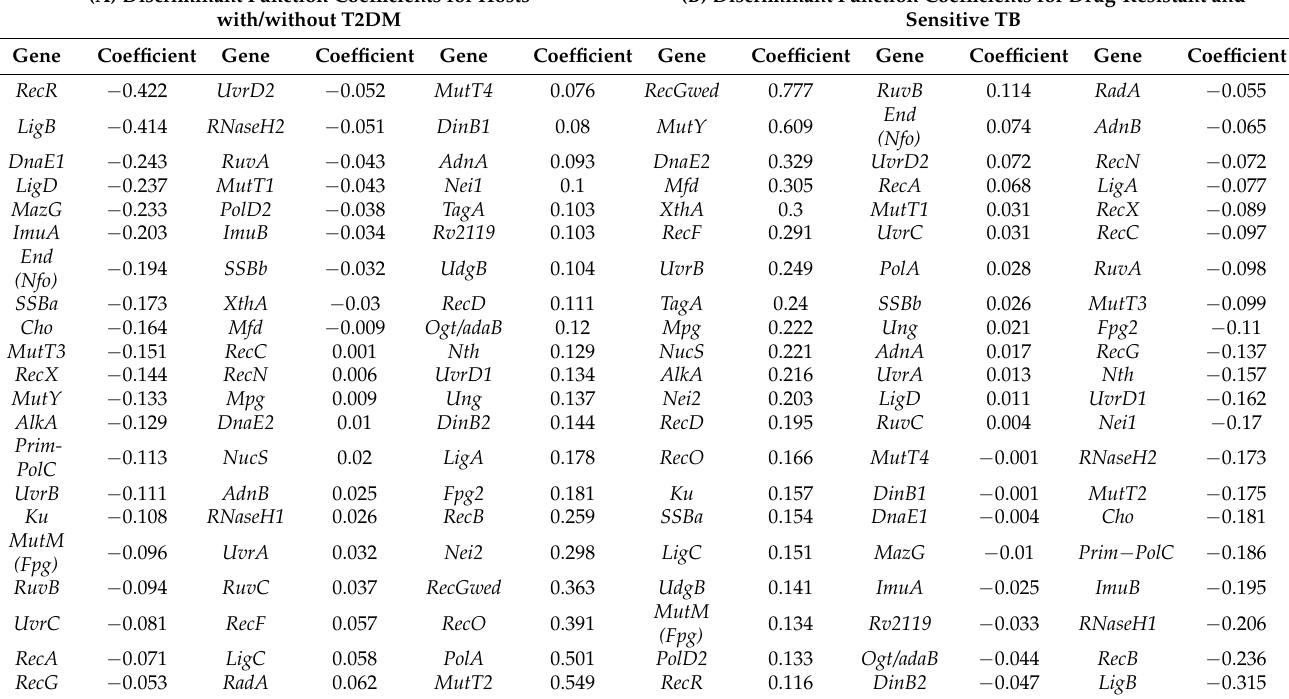
Table 5. Standardized coefficients of the canonical discriminant function for hosts with/without T2DM and drug-resistant TB. ( A ) Negative values indicate the presence of T2DM in the host and positive values indicate the absence of T2DM in the host. ( B ) Positive values indicate drug resistance and negative values indicate drug-susceptible